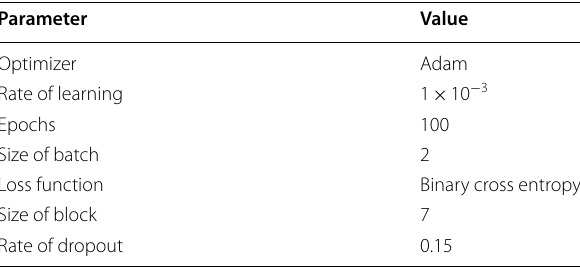
Table 2 Investigational parameters and their values for various models